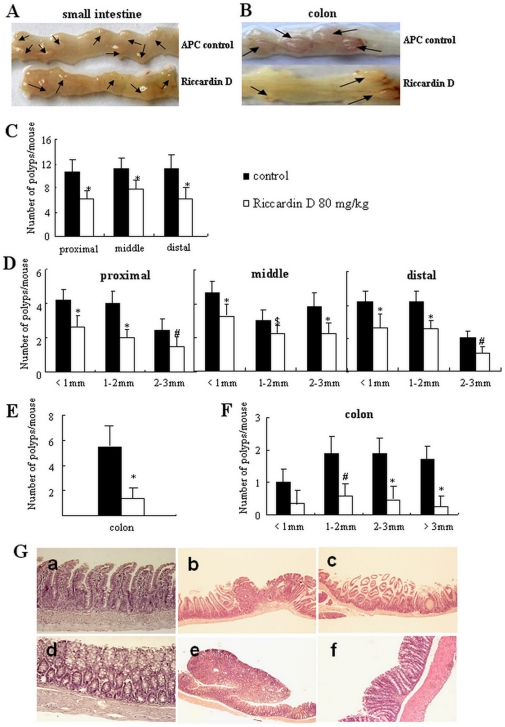
Riccardin D prevented spontaneous intestinal polyposis in APCMin/+ mice.(A and B): Representative pictures of distal small intestinal and colon polyps; (C): The number of polyps per mouse in different parts of small intestines; (D): The size distribution of polyps in different part of small intestines; (E): The number of polyps per mouse in colons; (F): The size distribution of polyps in colons. *, p<0.001; #, p<0.01; $, p<0.05 versus control. (G): Histological analysis of intestinal polyps. Sections of small intestine and colon from control or Riccardin D-treated mice were stained with hematoxylin and eosin (H&E) and analyzed under microscopy. a, Normal histology of small intestinal mucosa (100×). b, Small intestine of control mice showed an area of villus effacement and formation of a polyp with dysplastic glands. The central part of the polyp showed surface erosion and necrosis (40×). c, Riccardin D-treated small intestine showed an area of epithelial hyperplasia without obvious dysplasia. The villus architecture in polypoid area is well preserved (40×). d, Normal histology of colonic mucosa (100×). e, Colon from control mice showed a large pedunculated tubular adenoma (40×). f, Colon in mucosa of Riccardin D-treated mice showed well preserved crypt architecture with normal surface maturation. The surface epithelium showed minimal evidence of hyperplasia (40×).